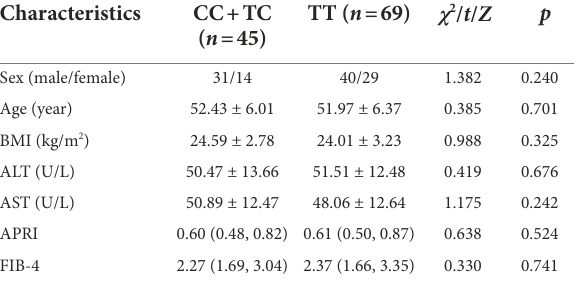
TABLE 4 Associations of rs6427384 genotypes with demographic and clinical characteristics. Characteristics